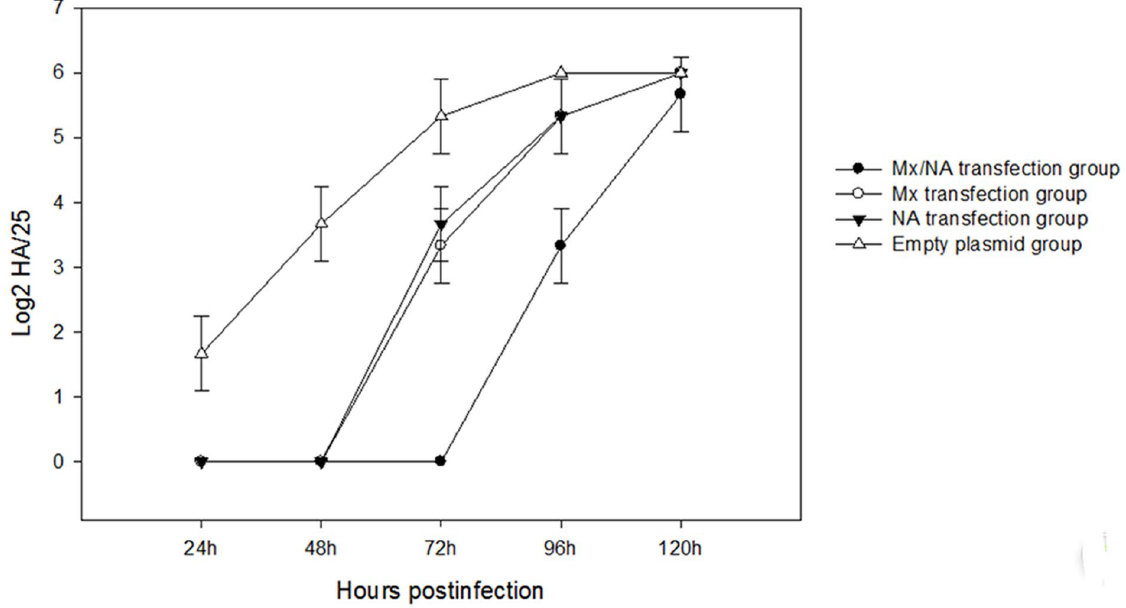
Figure 5. HA of transfection group infected NDV at different time. After G418 selection for two weeks, the transfected CEF cells were trypsinized and seeded into 24-well plates. After overnight cultivation, 100 TCID50 NDV was added to each well (in triplicates) and incubation was continued for 1 h at 37 u C. After 24, 48 and 72 h infection, supernatants of the cell cultures were collected for NDV titration on CEF cells.